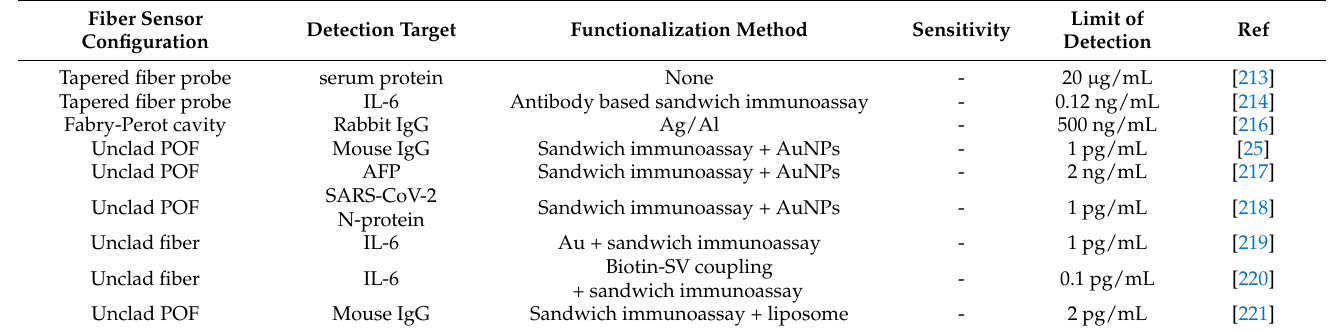
Table 5. Fluorescence-based fiber biosensors for protein detection.